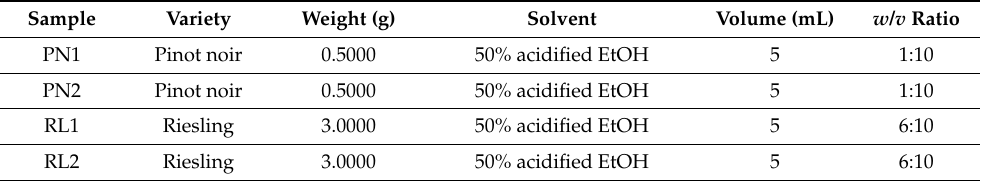
Table 2. Weight/Volume ratio (g freeze-dried sample/mL) used in solvent